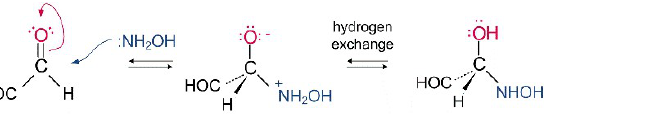
Table 4. Comparison of the observed and calculated anharmonic wavenumbers for